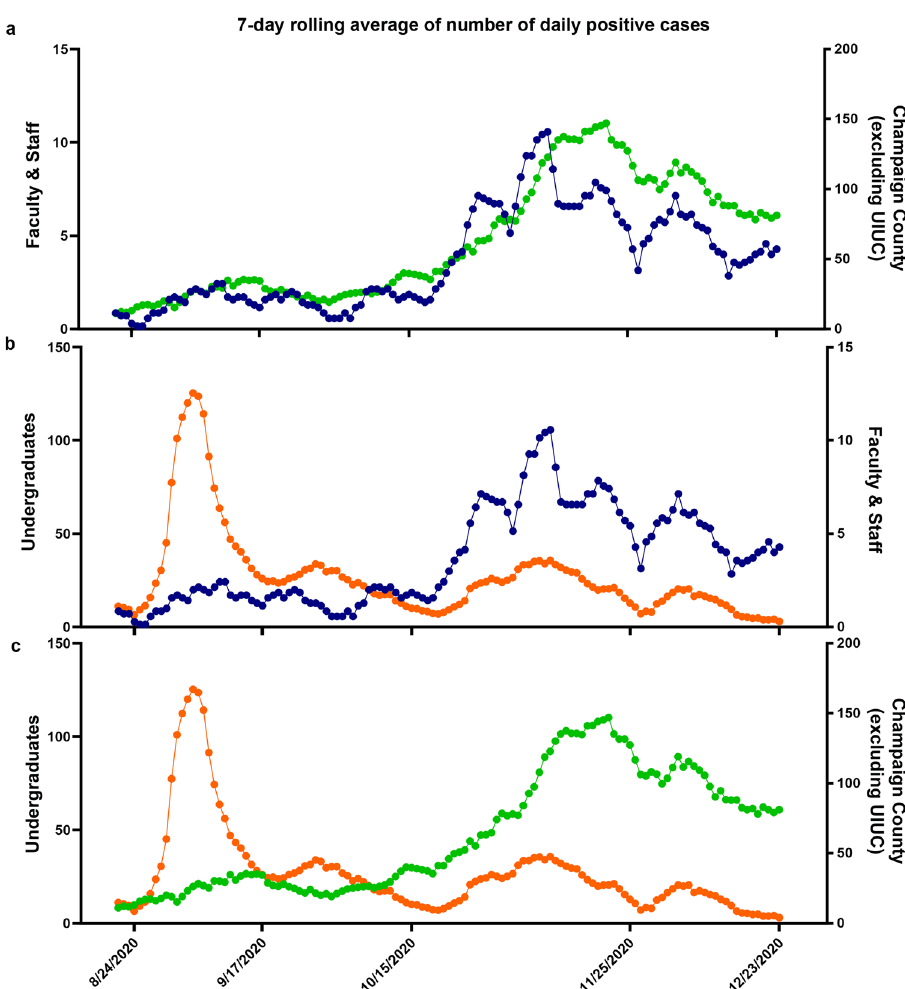
Fig. 5 Mitigation of SARS-CoV-2 spread in the context of the larger Champaign-Urbana Community. The daily number of 7-day averaged daily new cases between faculty/staff and residents in Champaign County a , undergraduates and faculty/staff b , and undergraduate students and residents in Champaign County c , for the period between August 15 and December 23. All points in three plots are colored according to their categories (orange: undergraduate students, blue: faculty/staff, green: residents in Champaign County). Pearson correlation coef fi cient, 95% con fi dence interval, and p -values for two-tailed test were calculated using GraphPad Prism